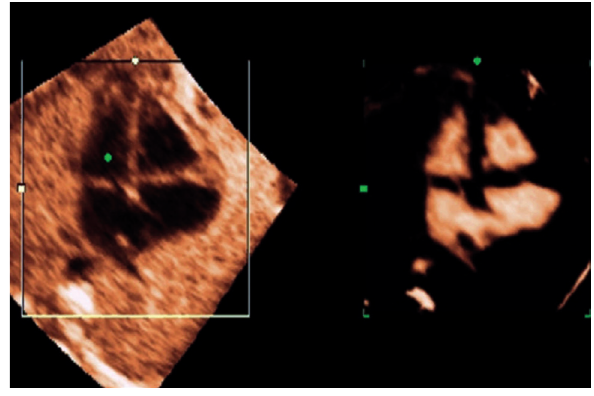
Fig. 1 – Visualization of four heart chambers plane using the inversion mode